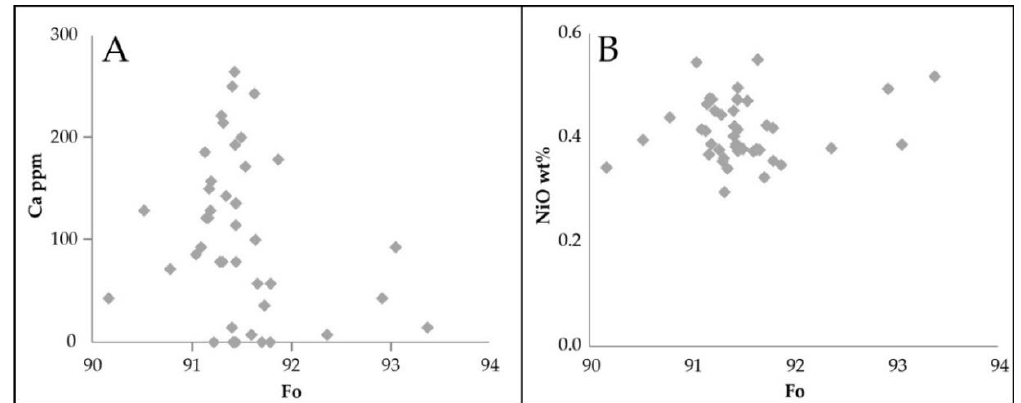
Figure 12. Variation of Ca ppm ( A ), NiO 2 wt% ( B ) as a function of forsterite molar % in the olivine from marine sediments.